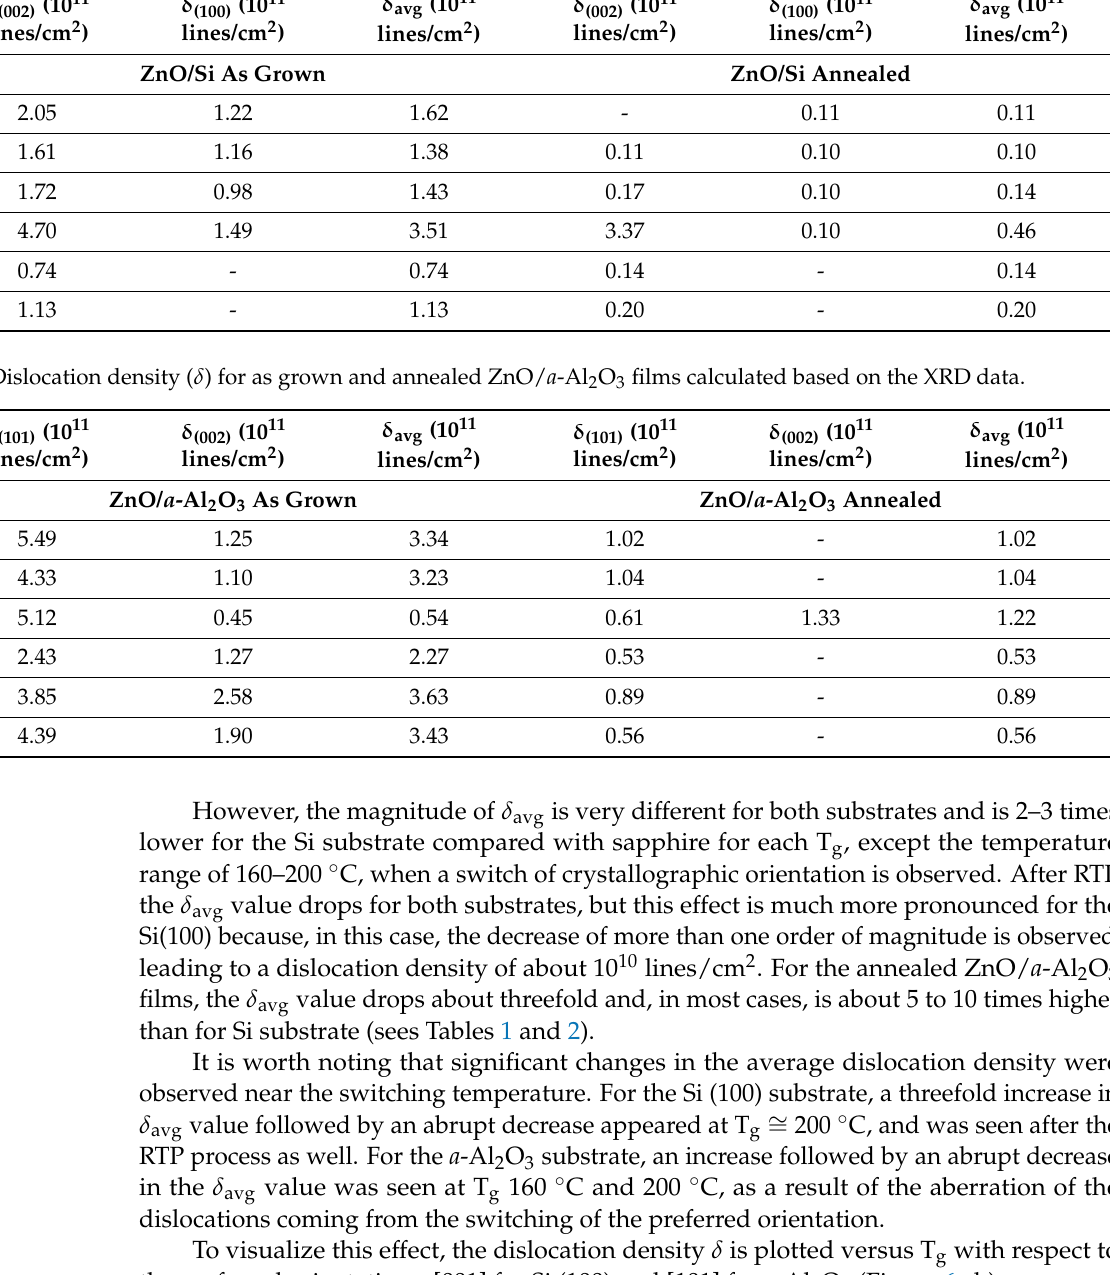
Table 1. Dislocation density ( δ ) for as grown and annealed ZnO/Si (100) films calculated based on the XRD data. T g ( ◦ C)